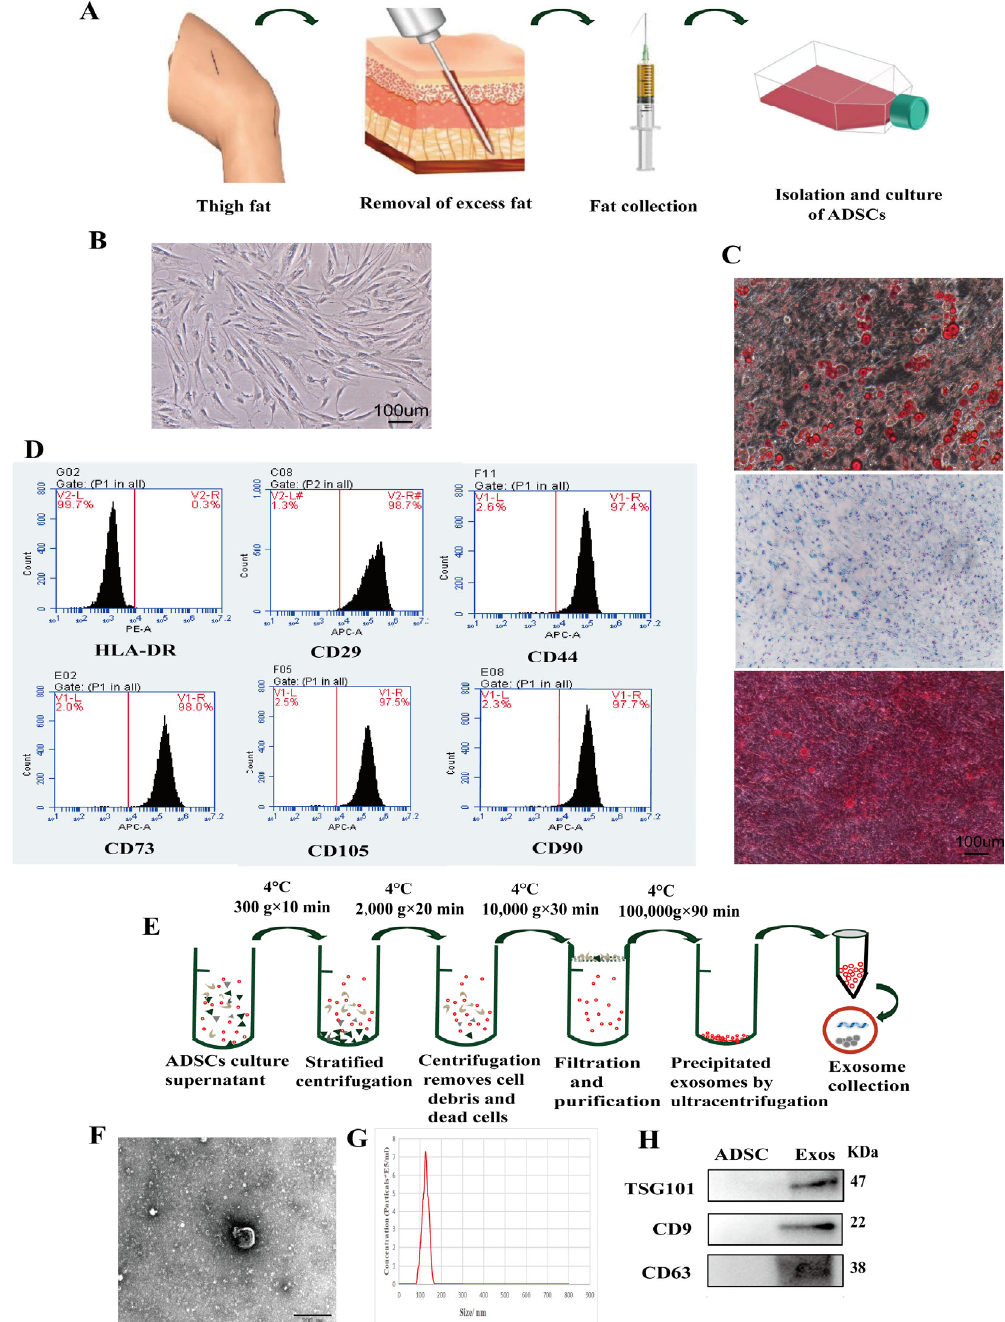
Figure 1. Isolation and characterization of ADSCs. ( A ) Liposuction of human subcutaneous fat and the isolation process of ADSCs. ( B ) Morphology of third ‐ generation ADSCs (Bar = 100um). ( C ) Adipogenic, chondrogenic, and osteogenic differentiation of ADSCs. Adipogenesis was specifically identified by Oil Red O staining, chondrogenesis by Alcian Blue staining, and adipogenesis by Alizarin Red staining. (Bar = 100um). ( D ) Flow cytometric analysis of ADSC ‐ Exo bio ‐ makers. CD29, CD44, CD73, CD90, and CD105 were highly expressed on ADSCs but HLA ‐ DR was rarely expressed. ( E ) The process of ADSC ‐ Exo isolation. ( F ) Morphology of ADSC ‐ Exos observed by transmission electron microscopy (Bar = 200nm). ( G ) The diameter size distribution of ADSC ‐ Exos was detected by nanoparticle tracking analysis (NTA). ( H ) The protein expression of CD9, CD63 and TSG101 was elevated in ADSC ‐ Exos.